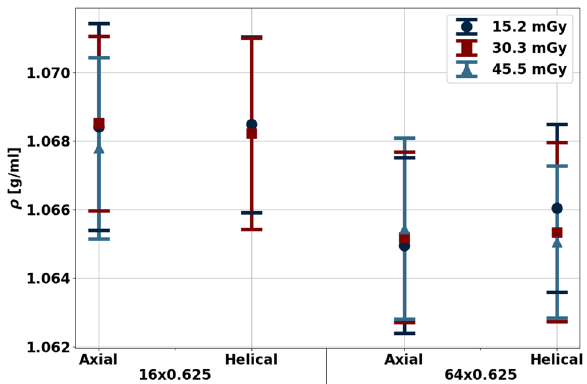
Figure 4. Spectral physical density quantifications at different doses, collimations, and axial/helical scans. With dose matched scans and different collimations, physical density decreased approximately 0.003 g/mL with increased collimation. There was no effect of dose and axial/helical scans on physical density quantifications.